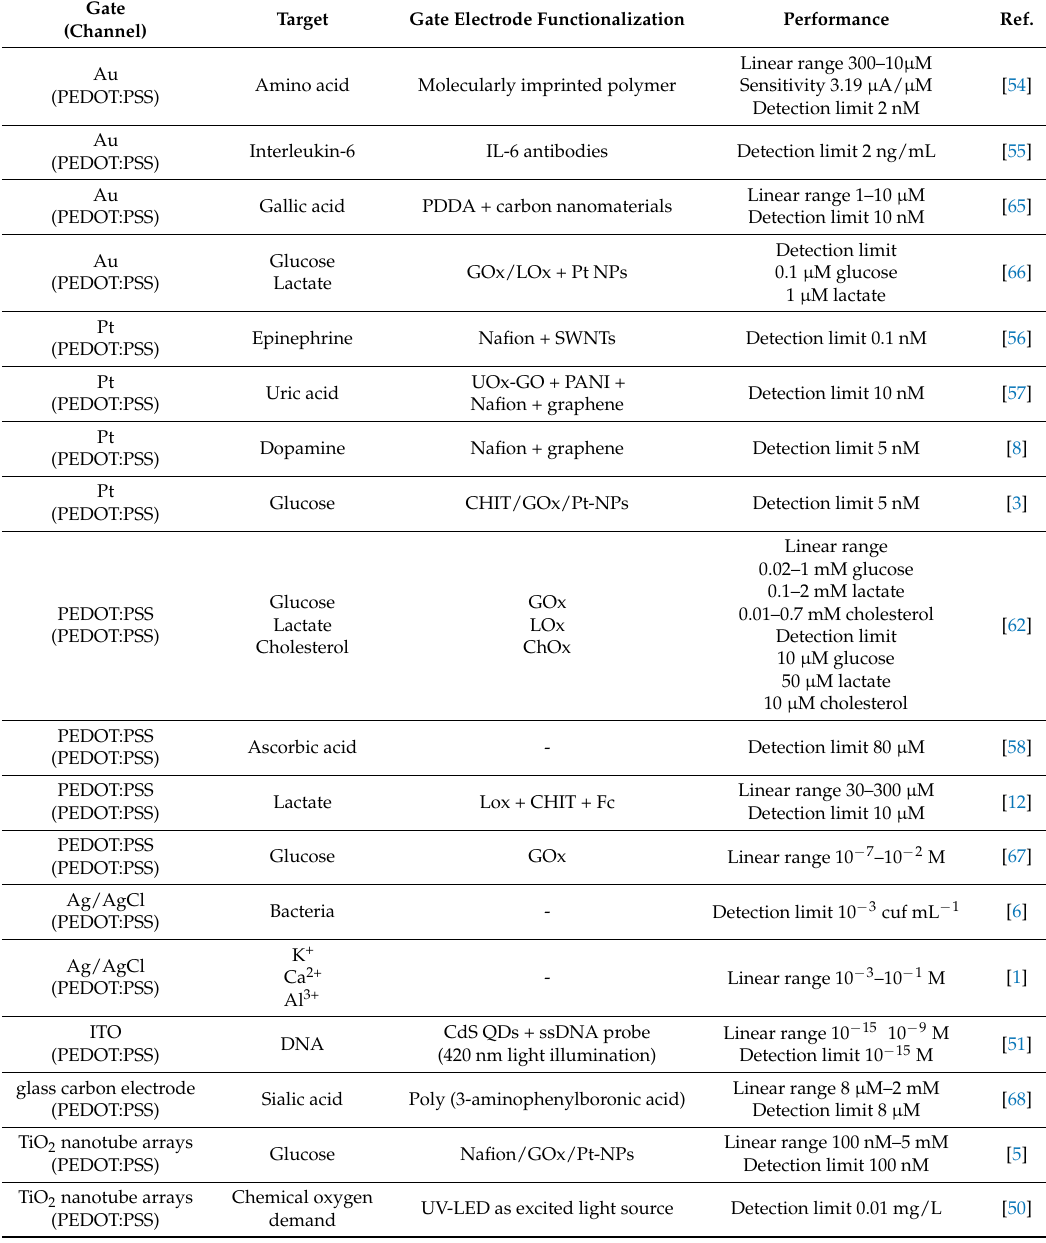
Table 3. Functionalization of OECT gate surface for bioelectric